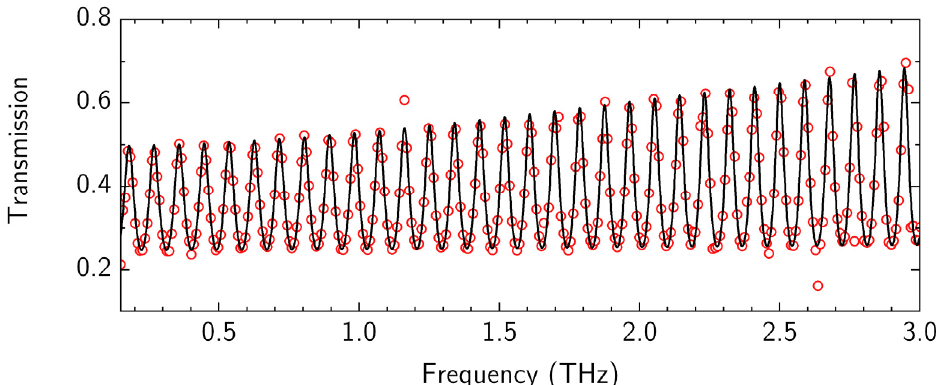
Figure 8. The THz transmission spectrum of graphene on HR Si wafer (DUV3 sample). The experi- mental data (red circles) was described by Drude conductivity model (black line), the usage of which allows one to estimate the electrical conductivity of the graphene.